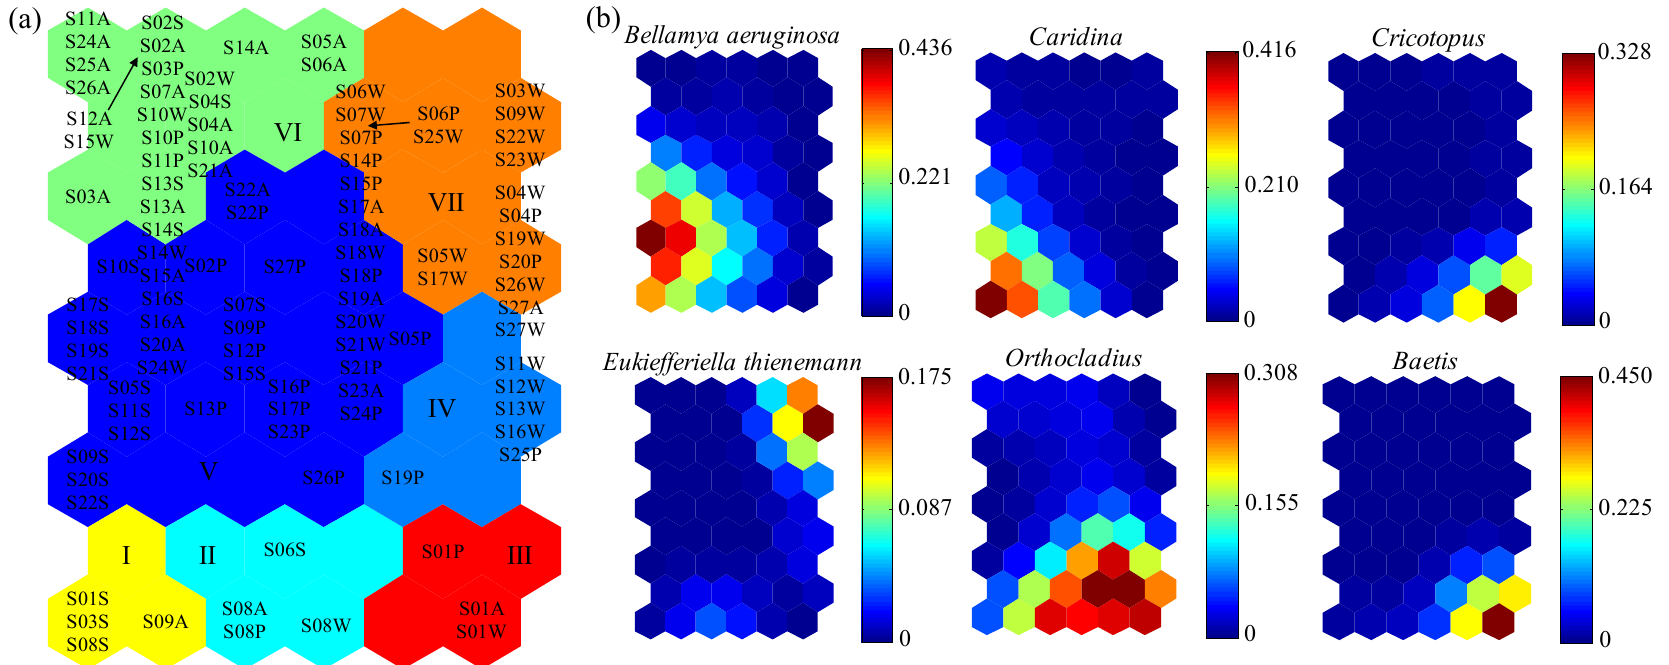
Figure 6. ( a ): distribution and clustering of samples on the self-organizing map (SOM) according to the abundance of 72 macroinvertebrate taxa. Codes within each hexagon correspond to individual samples (S: summer, A: autumn, W: winter, P: spring, 01–27 sampling stations) which were derived from the k -means algorithm applied to the weights of the 72 taxa in the 60 output neurons of the SOM; ( b ): profile of abundance of the prevalent taxa matched to clusters based on the trained SOM. The values in the vertical bar indicate densities (individuals/m 2 ).